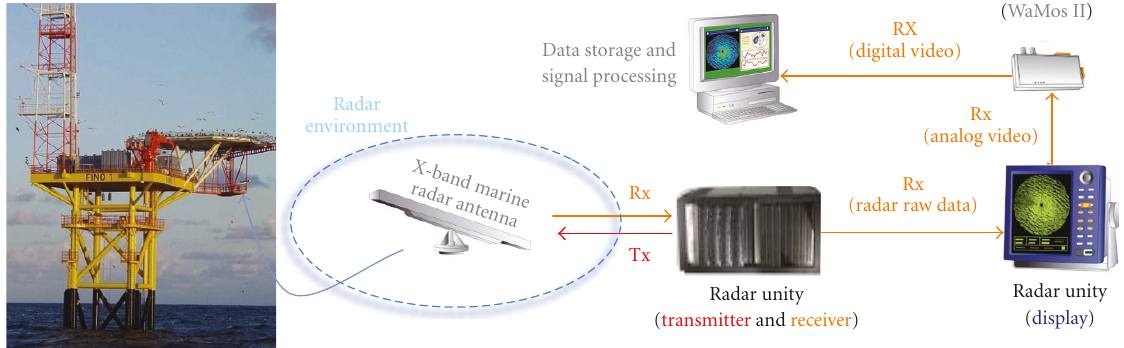
Figure 1: Measuring and monitoring maritime